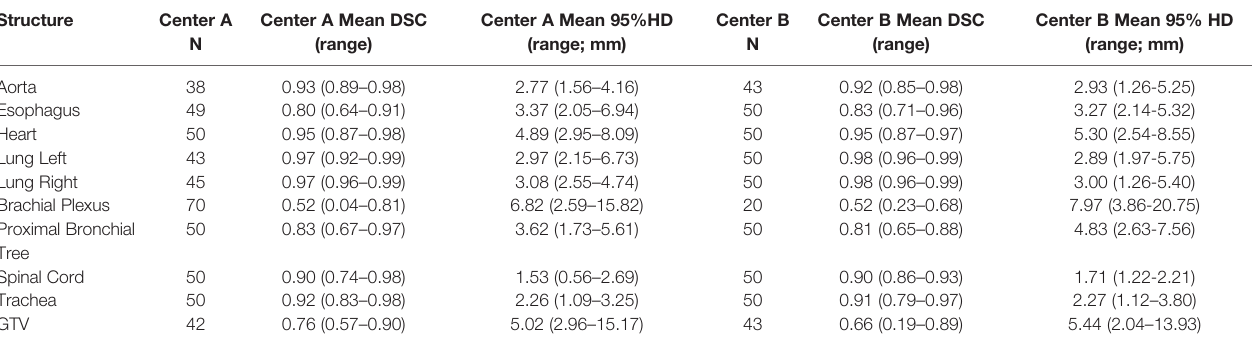
TABLE 2 | Summary of Dice Similarity Coef fi cient (DSC) and 95% Hausdorff distance (HD) metrics from comparing deep learning-based auto-segmented contours to clinical contours for center A and center B lung stereotactic ablative radiotherapy planning structures.